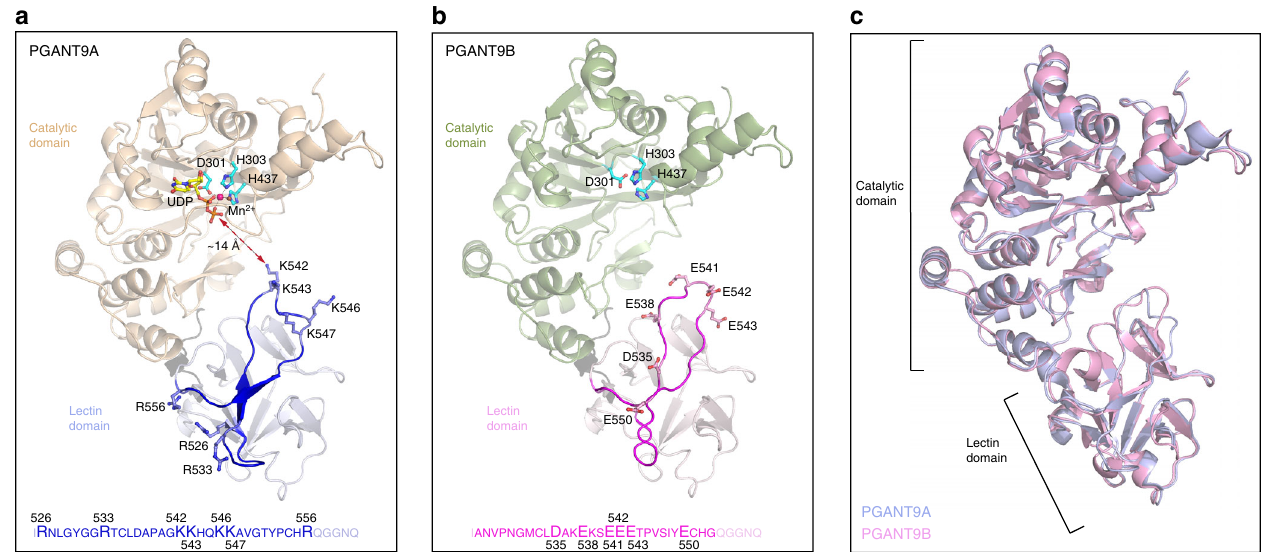
Fig. 5 Crystal structures of PGANT9A and PGANT9B reveal divergent substrate preferences. a Crystal structure of PGANT9A with the catalytic domain shown in wheat and the lectin domain shown in light blue. The active site residues D301, H303, and H437 are in cyan, Mn 2 + in magenta, and UDP in yellow. The variable α subunit is in dark blue, and the positively charged residues are shown as sticks. The variable region sequence is in dark blue and the residues shown in the structure are in larger font. The conserved residues on the peripheries are shown in light blue. b Crystal structure of PGANT9B with the catalytic domain in green, the lectin domain in pink, and the α subunit in magenta (with negatively charged residues shown as sticks). The variable region sequence is in magenta and the negatively charged residues are in larger font, while the conserved residues on the peripheries are in light pink. c PGANT9A and PGANT9B adopt the same overall fold. PGANT9A is in light blue, and PGANT9B is in pink